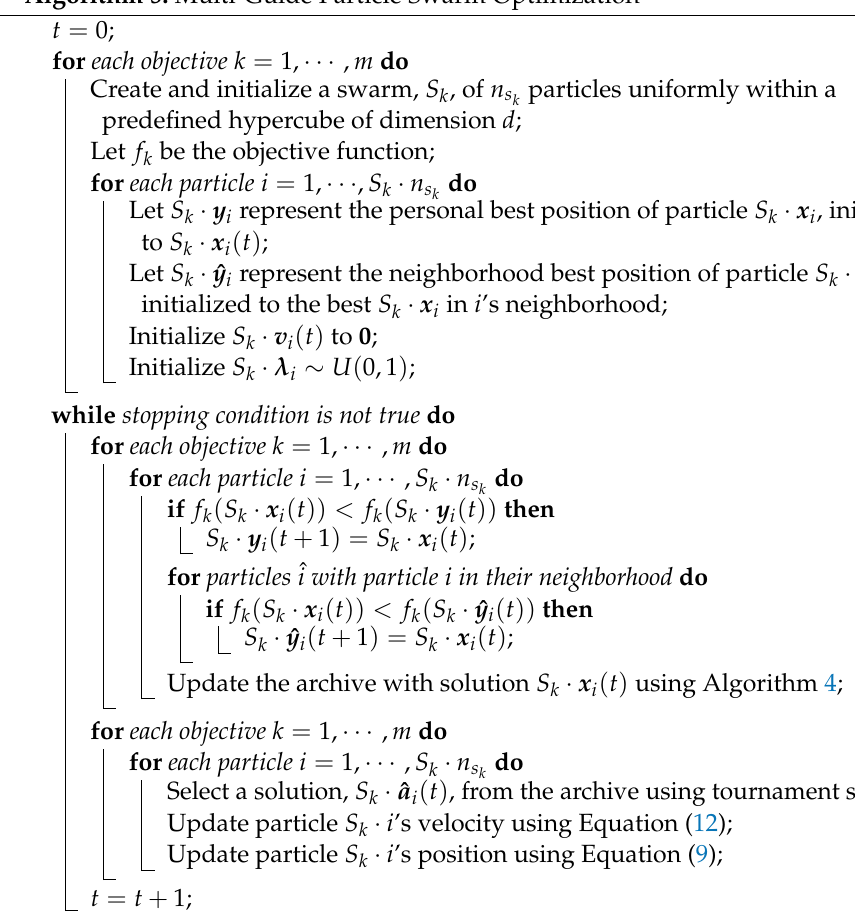
Algorithm 5: Multi-Guide Particle Swarm